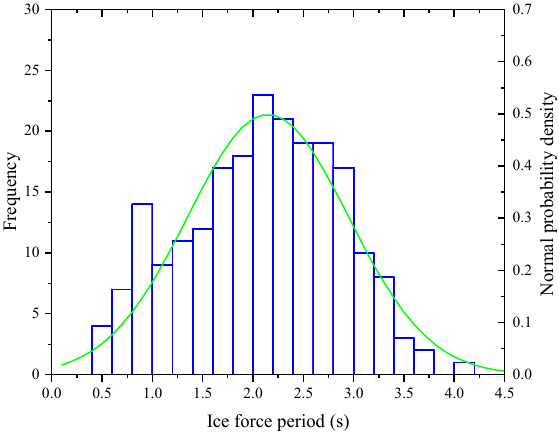
Figure 8. Normal distribution characteristics of ice periods.